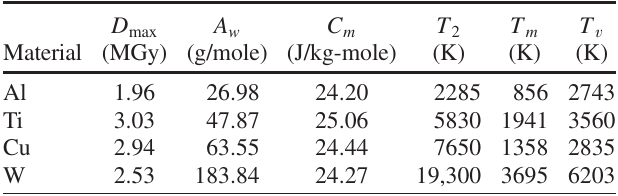
TABLE III. Examples of final peak temperatures in Al, Ti, Cu, and W using Eq. (2) based on the dose from a single 15.3-nC bunch at 6 GeV with APS-U beam parameters ( T 1 ¼ 300 K). T m and T v represent the melting and vaporization